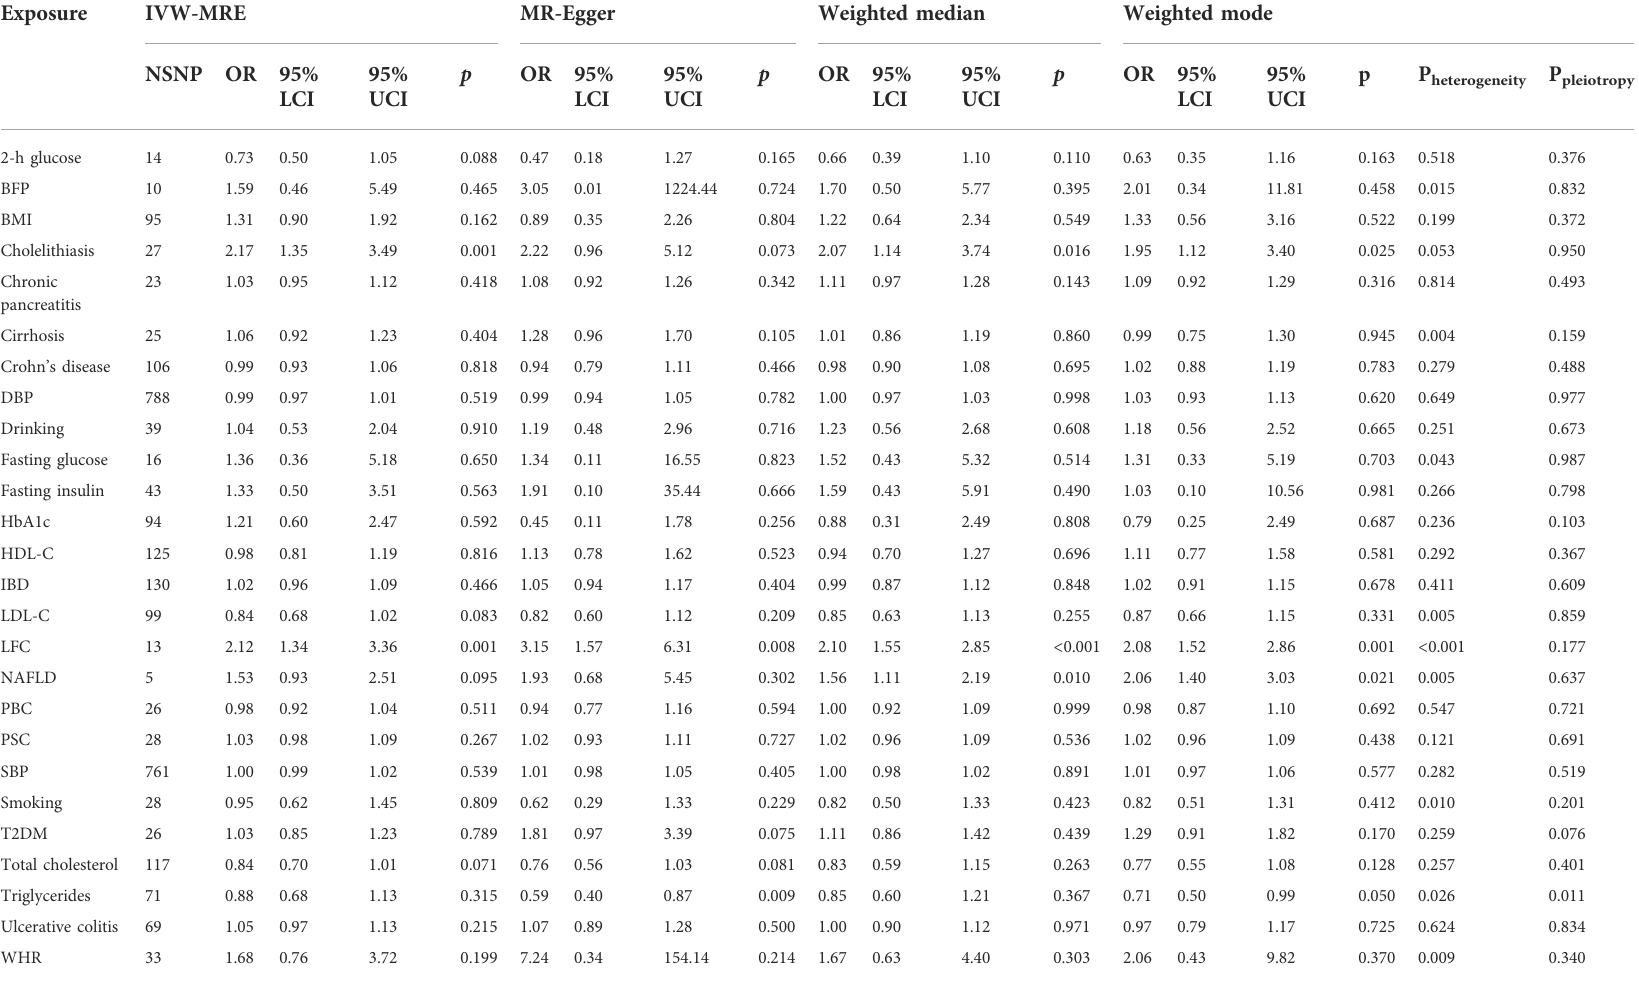
TABLE 2 Mendelian randomization results of the other applied methods.